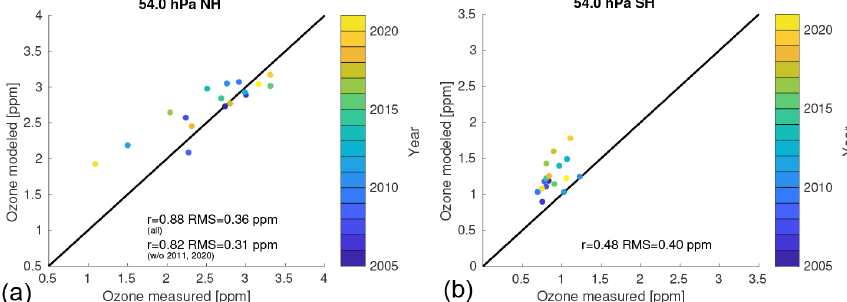
Figure 7. Scatter plots of the modeled ozone on the date of vortex breakup (with the full transport parameterization) versus the observed ozone from MLS (based on the same data as in Fig.